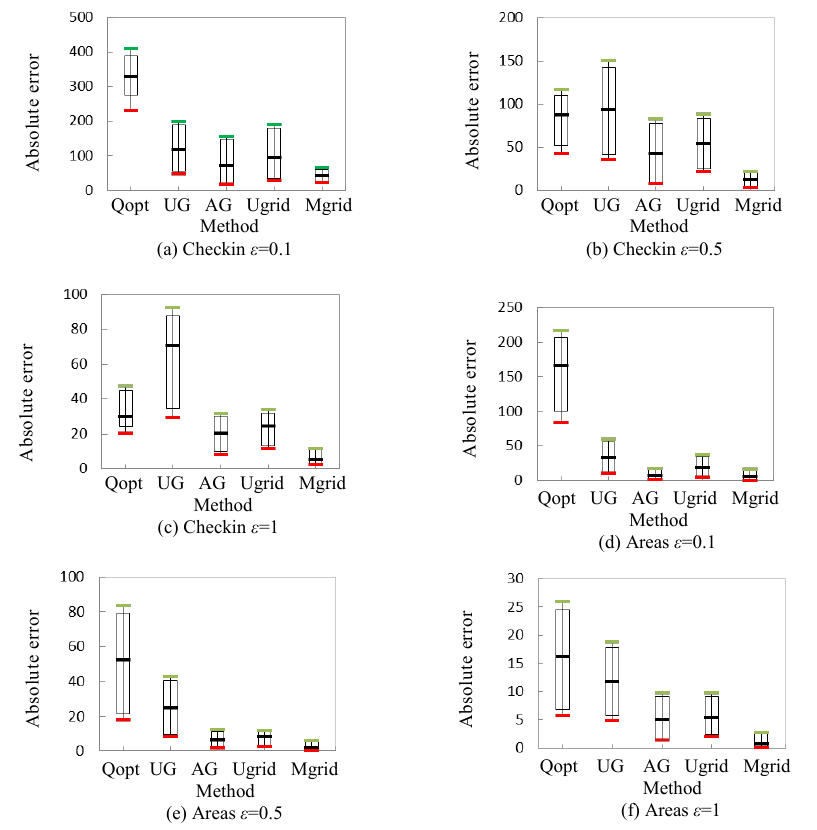
Figure 6. Absolute error of